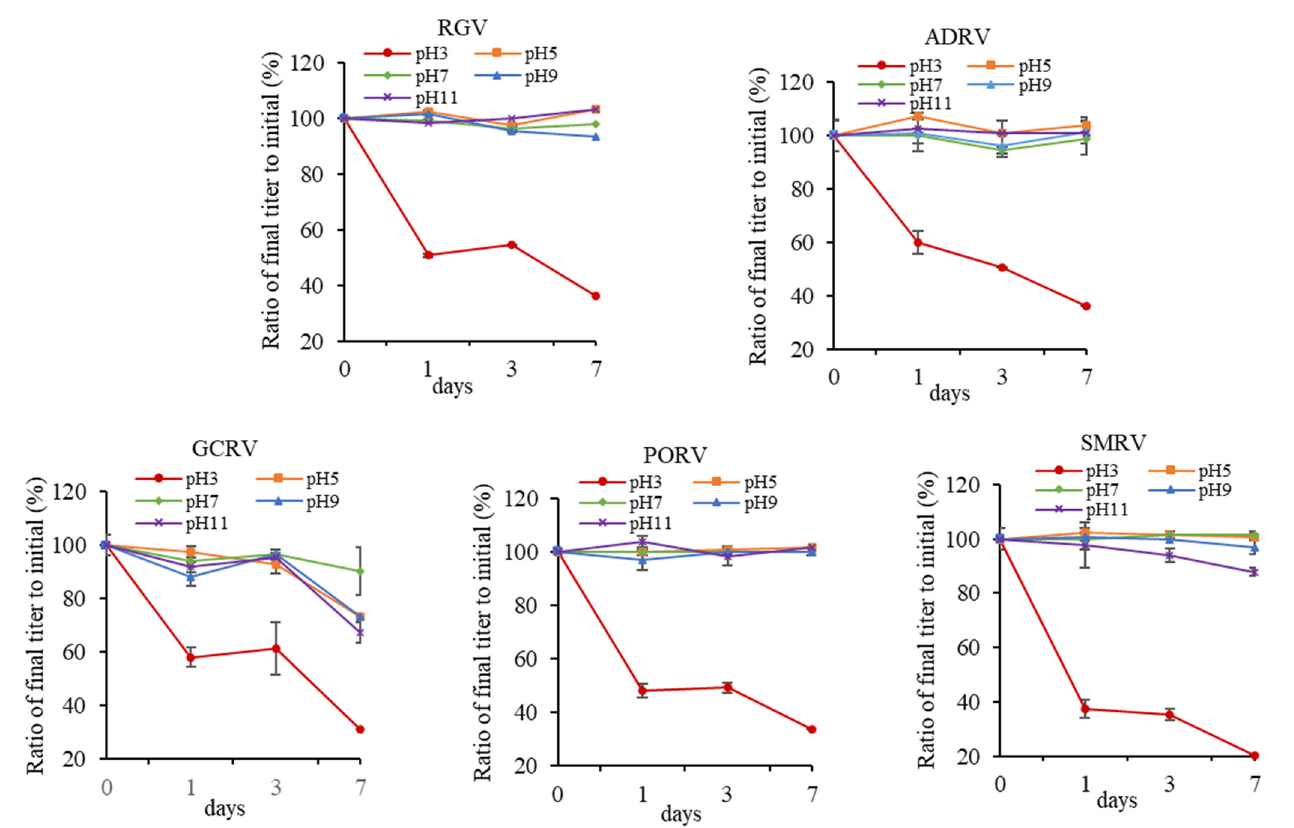
Figure 3. Effect of different pH (3, 5, 7, 9, and 11) on titers of five aquatic animal viruses. Each point in the figure showed the ratio of the titer after treatment to initial titer for each virus.